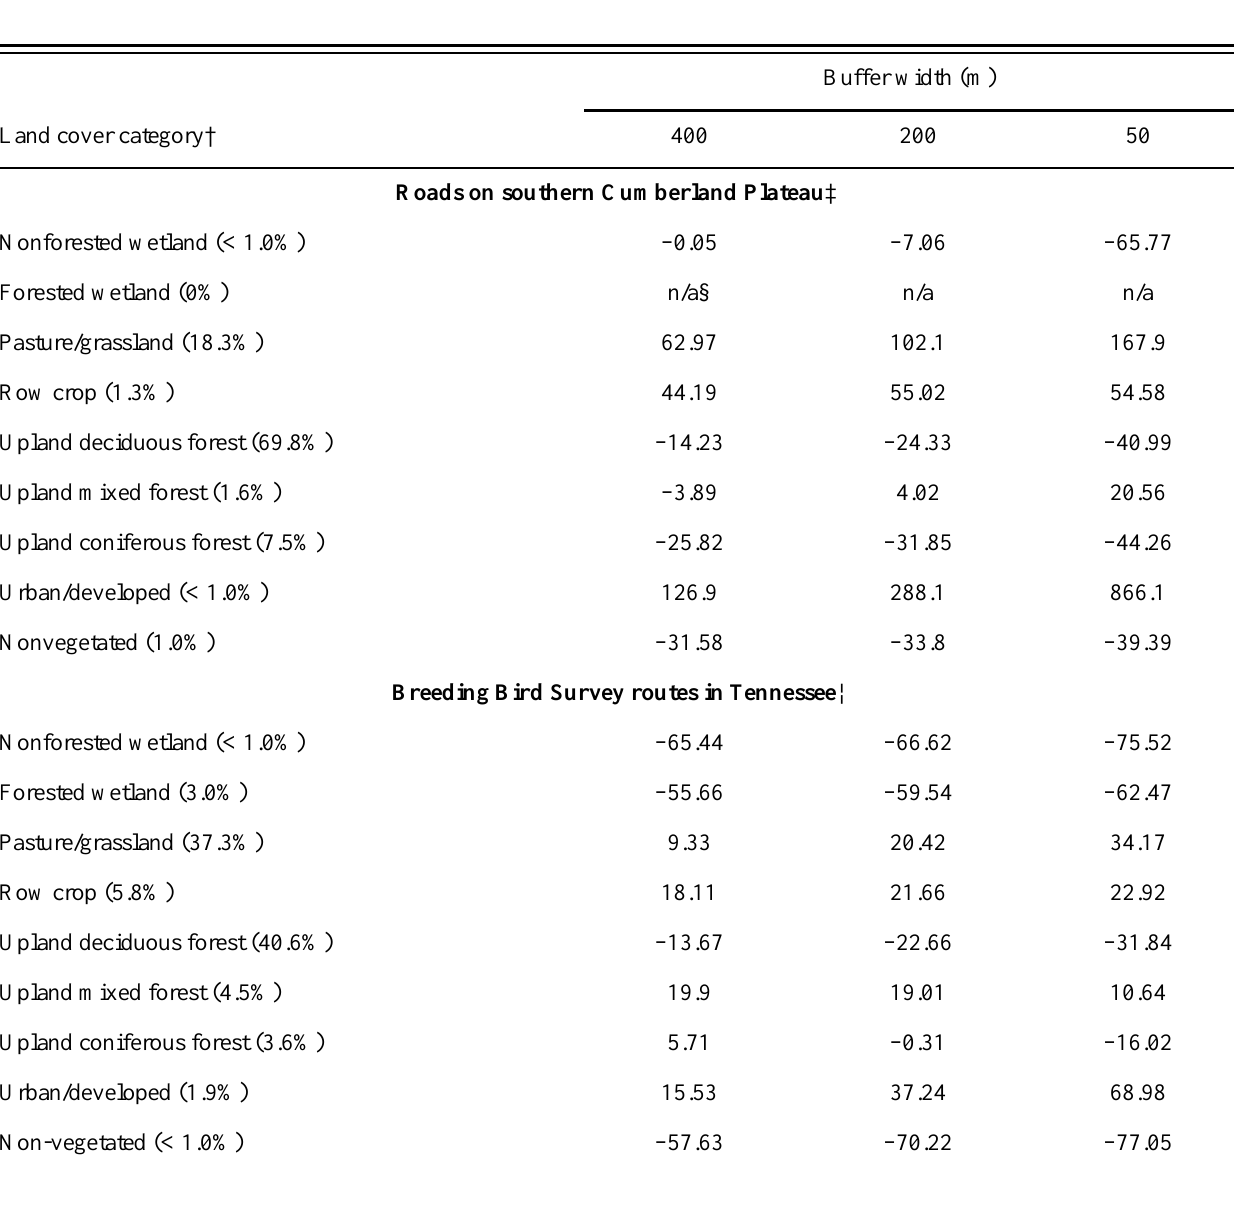
Table 5. Percentage over- (positive values) or underrepresentation (negative values) of land cover in roadside buffers of three widths compared to the land cover of the surrounding region for coarse-resolution land cover